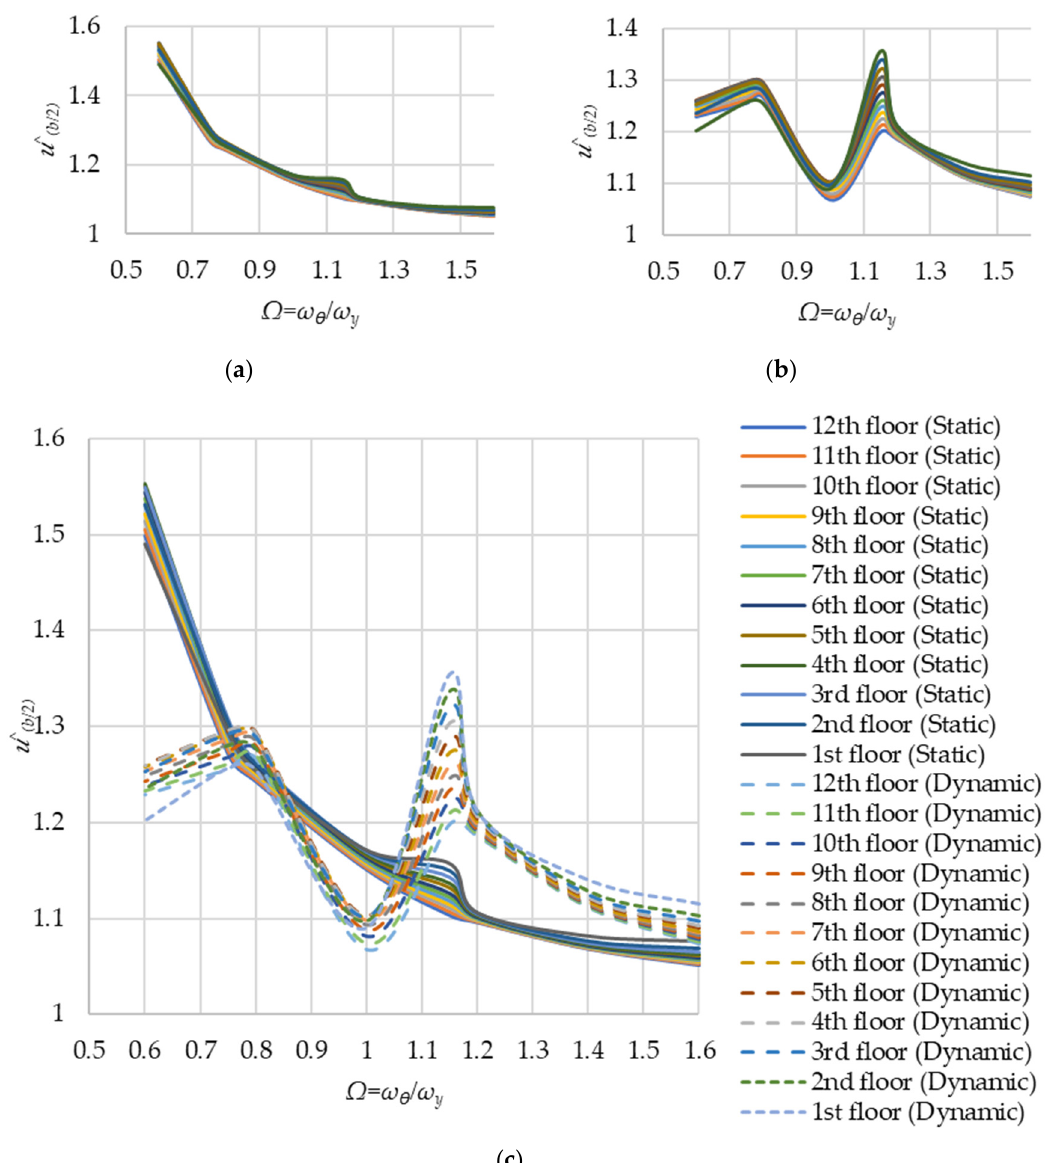
Figure 12. Normalized flexible edge displacement (with b / r = 2.45, 1 < Ty < 2 s): ( a ) Static edge displacement; ( b ) Dynamic edge displacement; ( c ) Static vs. dynamic edge displacement.